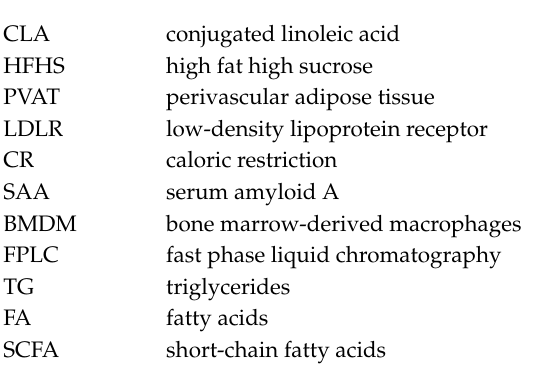
macrophages, Figure S3: CLA isomers do not alter the uptake of cholesterol by bone marrow-derived macrophages, Table S1: Phenotype summary of study mice, Table S2: Taqman